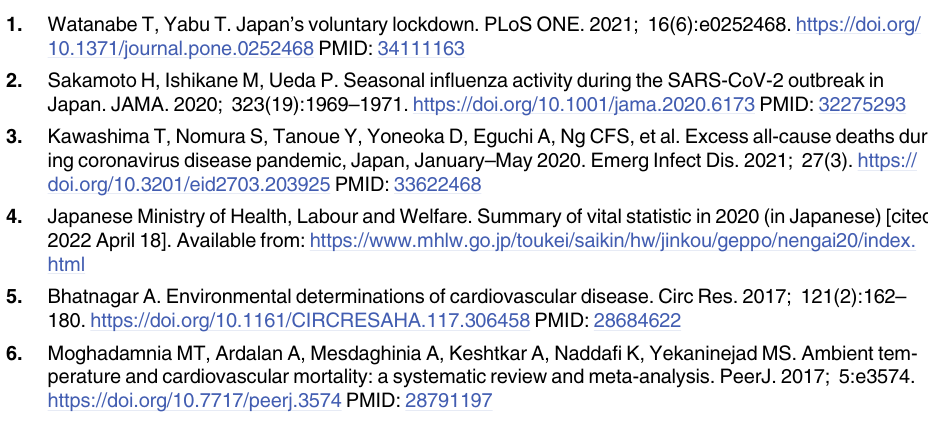
for respiratory diseases (Resp) estimated in this adj